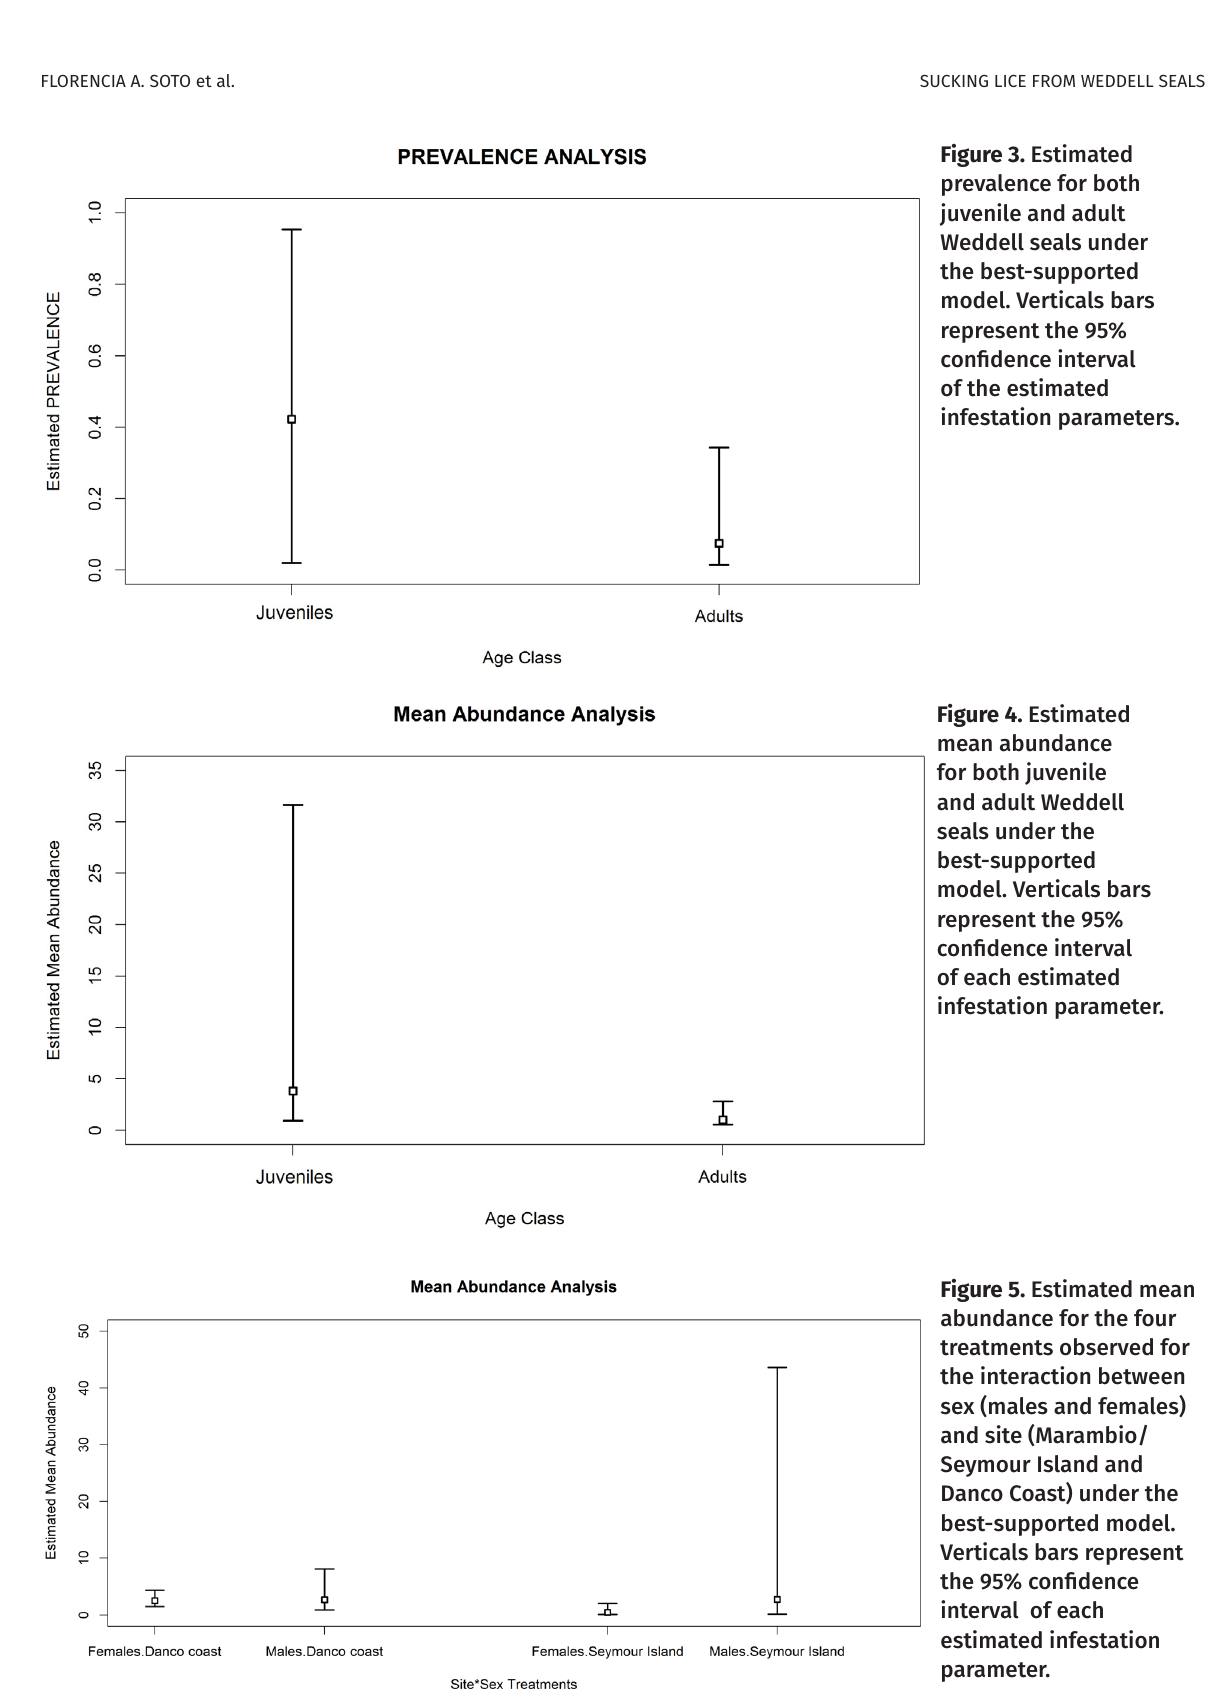
Figure 5. Estimated mean abundance for the four treatments observed for the interaction between sex (males and females) and site (Marambio/ Seymour Island and Danco Coast) under the best-supported model. Verticals bars represent the 95% confidence interval of each estimated infestation parameter.